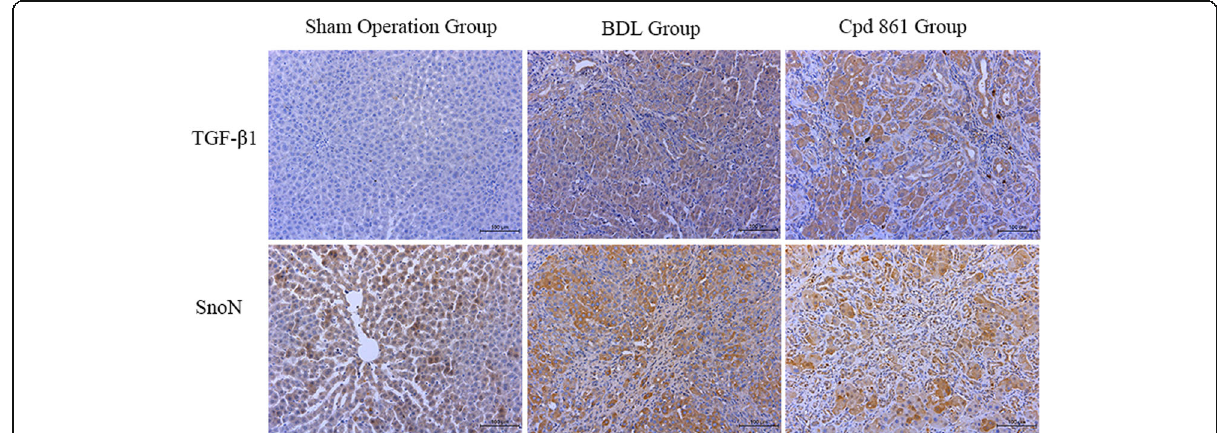
Fig. 4 Positive expression location of TGF- β 1 and SnoN for sham operation, BDL, and Cpd861 groups, as analyzed by immunohistochemistry assay